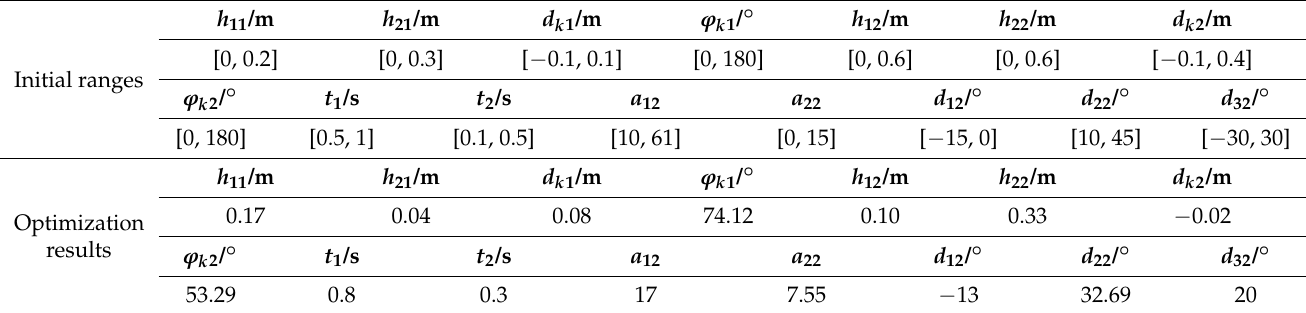
Table 3. Initial parameter ranges and optimization results for example